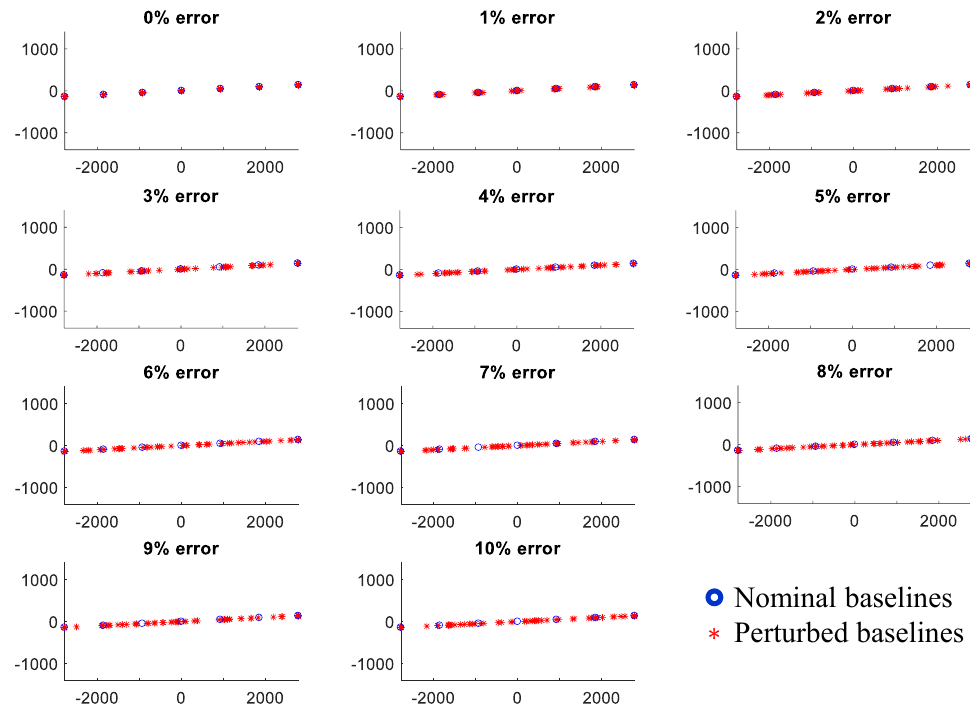
Figure 10. Sensor positions in the zero Doppler plane of the simulated spaceborne system; regularly spaced (nominal) positions are shown as blue circles, irregular positions as red asterisks. The irregular coordinates have been obtained by modifying the nominal positions with a Gaussian perturbation, the elevation above the Earth surface being kept constant. The amount of perturbation is defined by the standard deviation of the Gaussian noise as a percentage of the total baseline aperture. In this work, 11 perturbations have been tested from 0% to 10%. The corresponding sampling of the total baseline aperture is shown in the 11 panels here